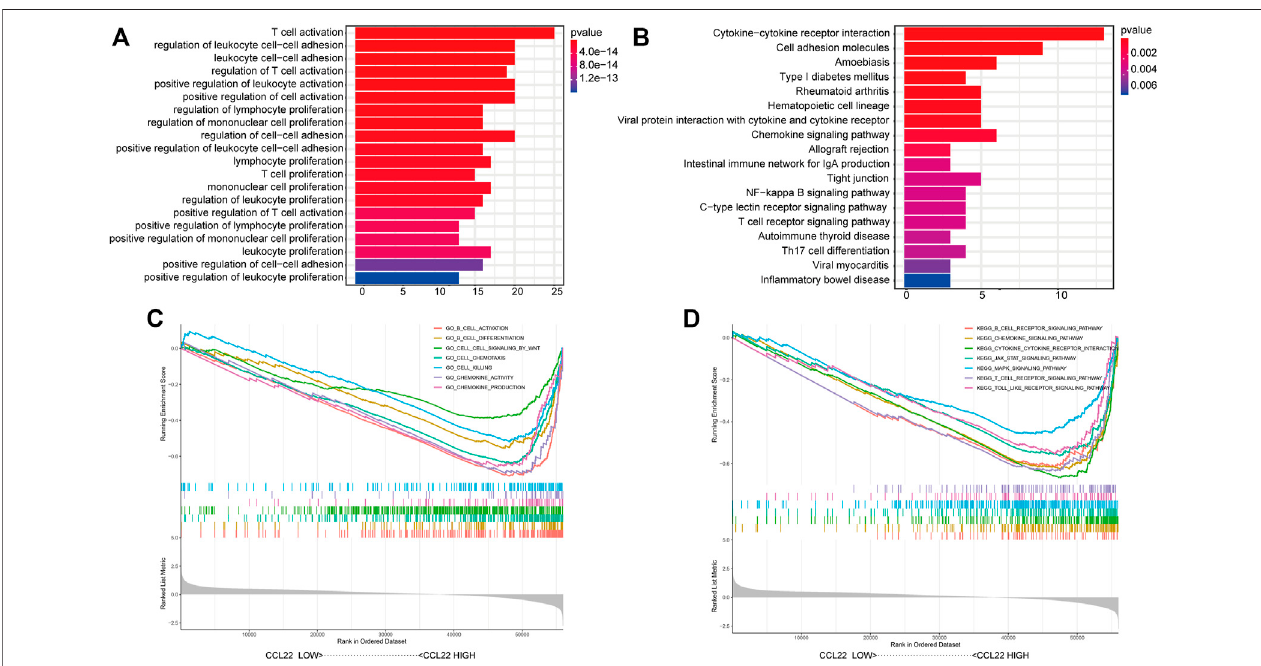
FIGURE 4 | Biological function analysis of CCL22. Representative Gene Ontology (GO) functions (A) and Kyoto Encyclopedia of Genes and Genomes (KEGG) pathways (B) ofthetop100geneswithexpressionsimilartoCCL22.RepresentativeGeneSetEnrichmentAnalysisresultsofGOfunctions (C) andKEGGpathways (D) based on